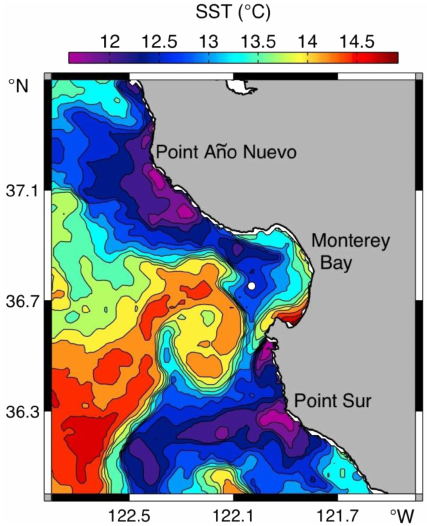
Figure 1. Monterey Bay and Canyon. The location of the wave gauge (CDIP) and water level gauges are indicated with stars. Sta- tion information and coordinates for the CDIP buoy are provided in CDIP (2014), and for the tide gauges in NOAA (2014a). We classify bight modes as having periods between 2 and 15min with length scales between 2 and 10km, and bay modes with periods longer than 15min and scales from 10 to 40km.